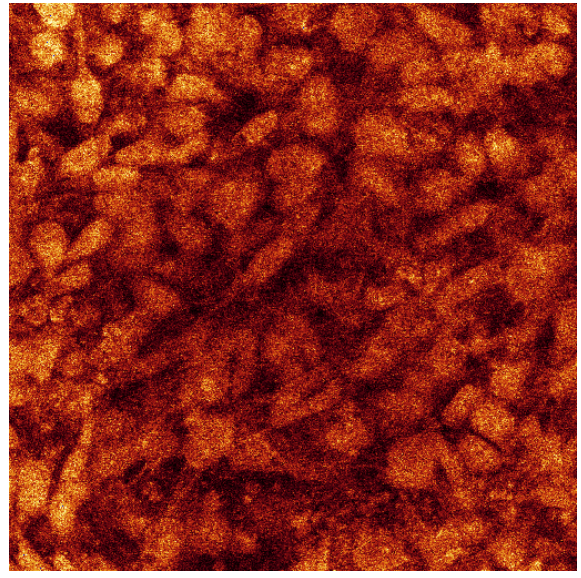
Figure 15. Confocal microscopy image all 173 sections for cell culture on SBF coating on less porous alumina Sample